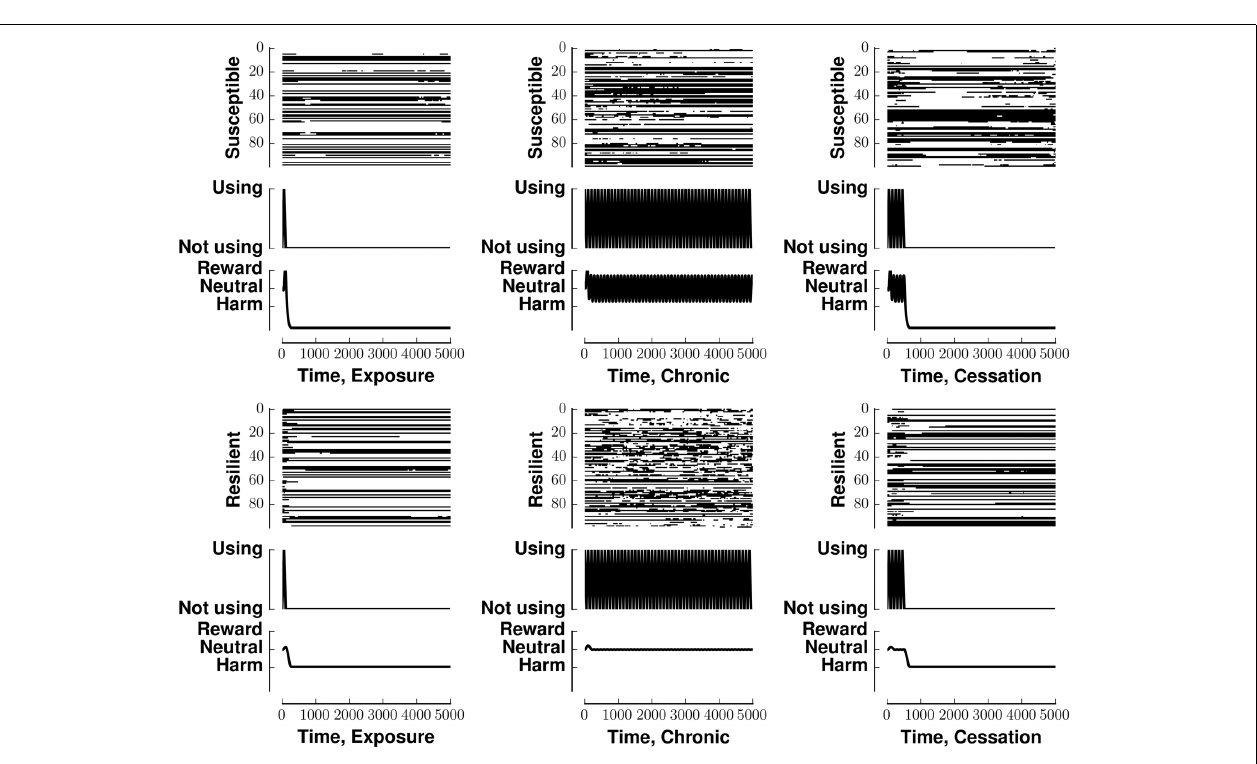
FIGURE 3 | Stability of network activity in the face of various stimulus-reward inputs. Each panel shows the raster (top), stimulus (middle), and associated reward (bottom) for one of the six stimulus-reward patterns from Figure 2 . The row (x-label of raster) indicates the reward pattern, susceptible or resilient. The column (y-label of raster) indicates the